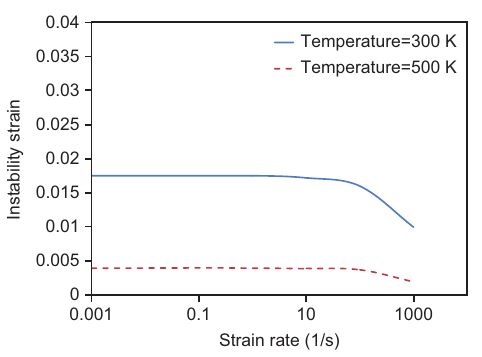
Figure 18 Occurrence of instability strain vs. strain rate for CR-1018 steel.